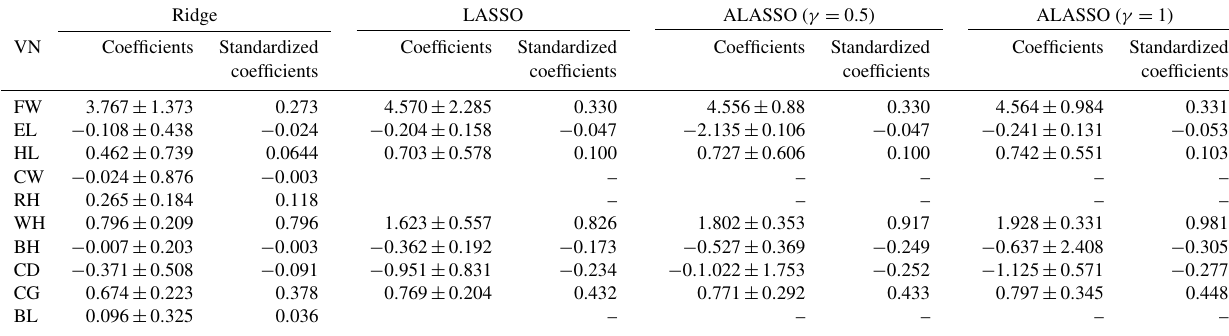
Table 3. Coefficients and standardized coefficients of Ridge, LASSO, and ALASSO ( γ = 0 . 5 and γ = 1) in multiple linear regression for male goats.